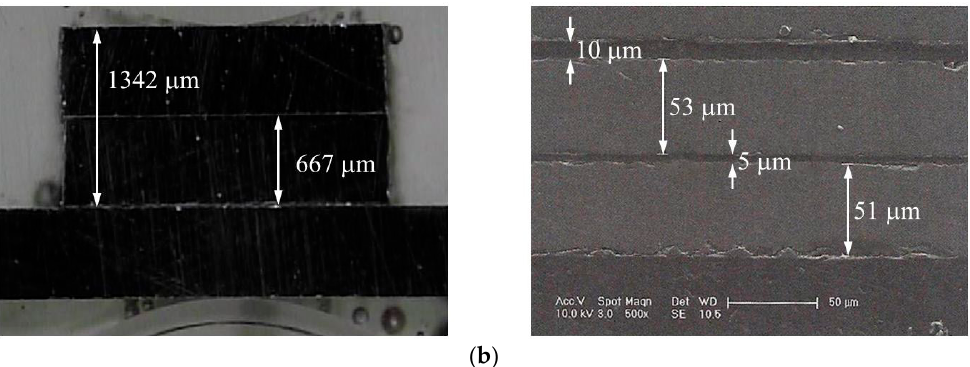
Figure 2. ( a ) Schematic of the silicon wafer stacked heat source chip (SSHSC); ( b ) Cross-section image